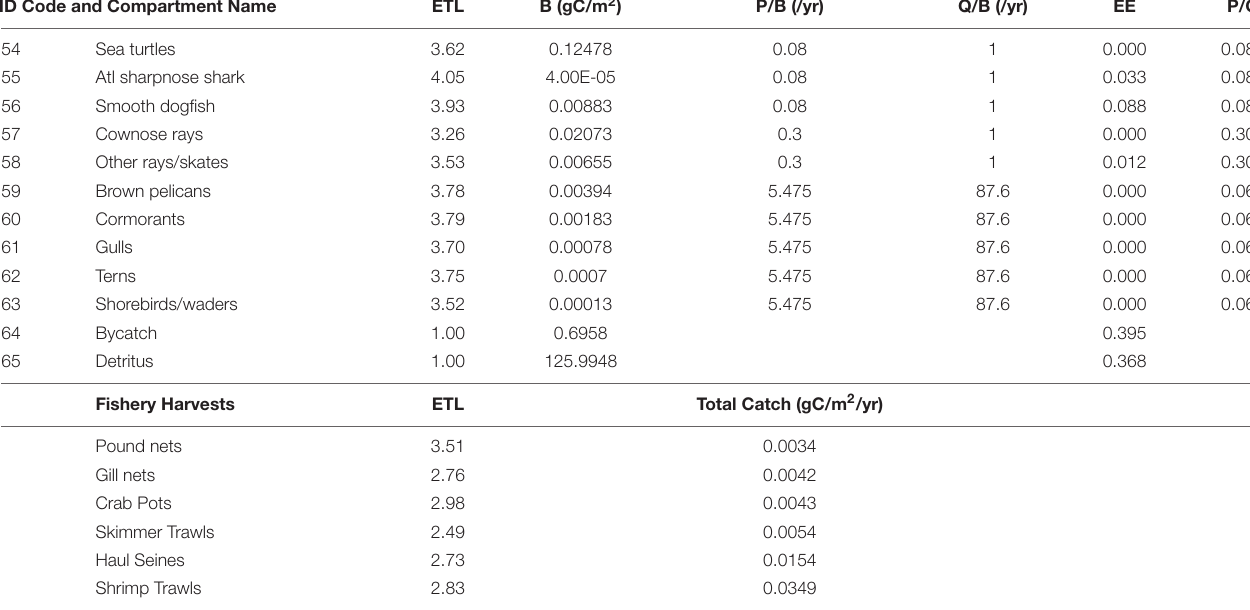
algorithm. Johnson’s hierarchical clustering strategy in